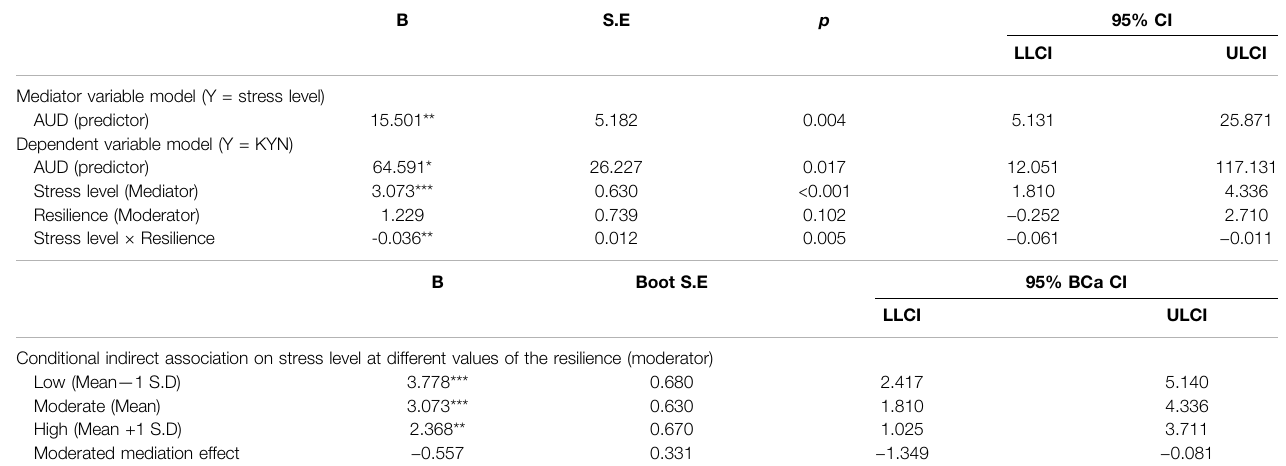
TABLE 2 | Moderated mediation model with AUD, stress level and KYN pathway metabolites ( n = 65, bootstrap = 5,000). B S.E p